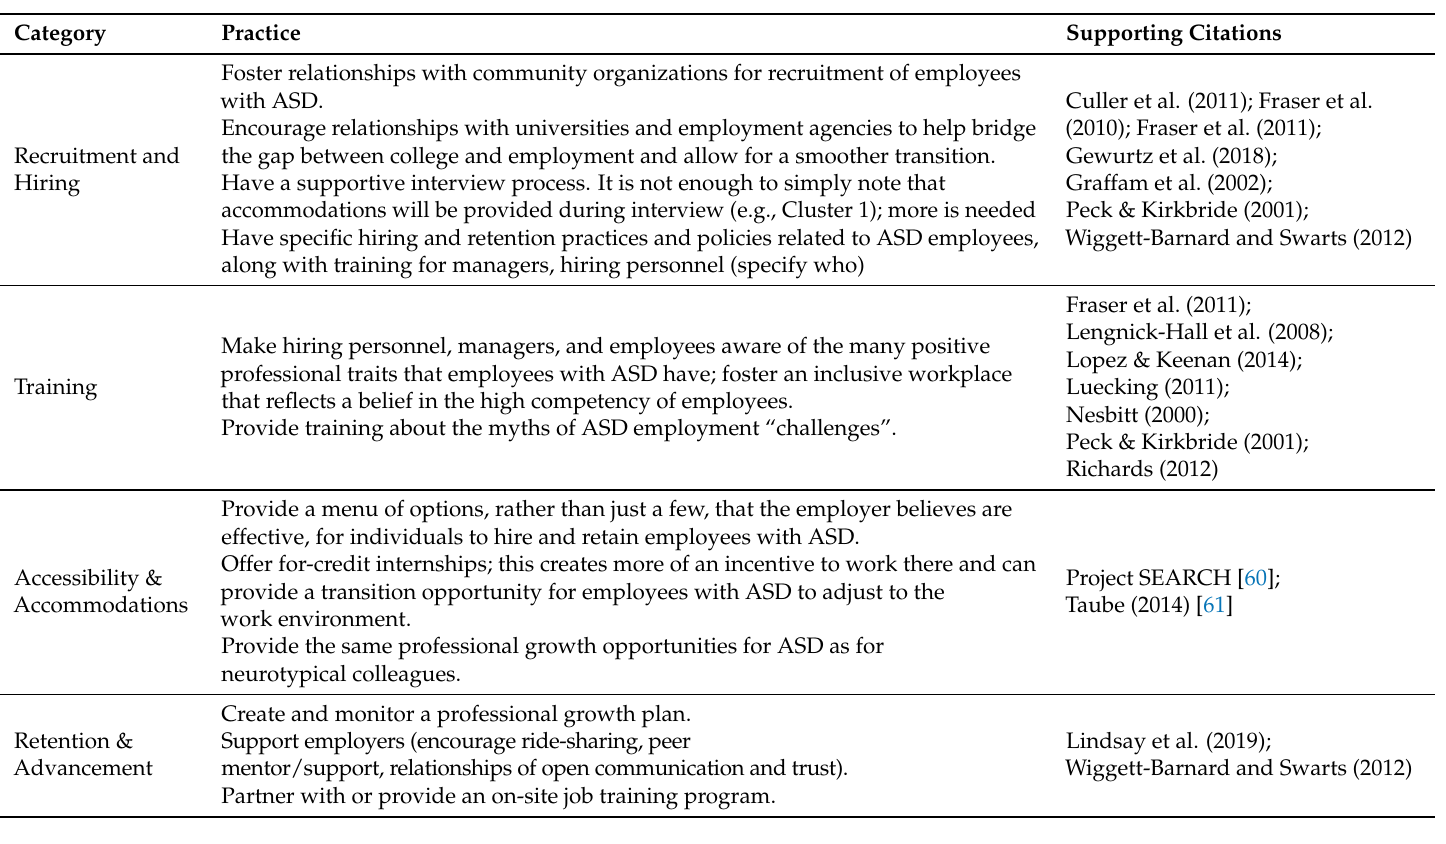
Table 6. Practices for improving employment of individuals with high functioning